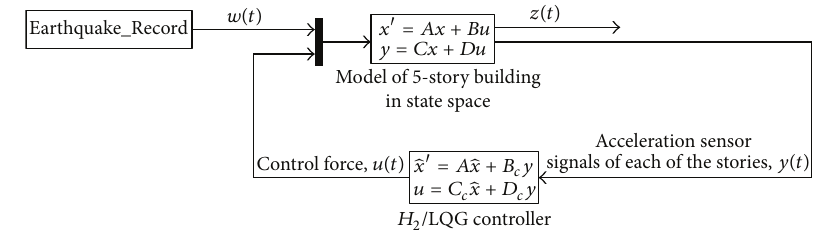
Figure 3: Simulink model in MATLAB.